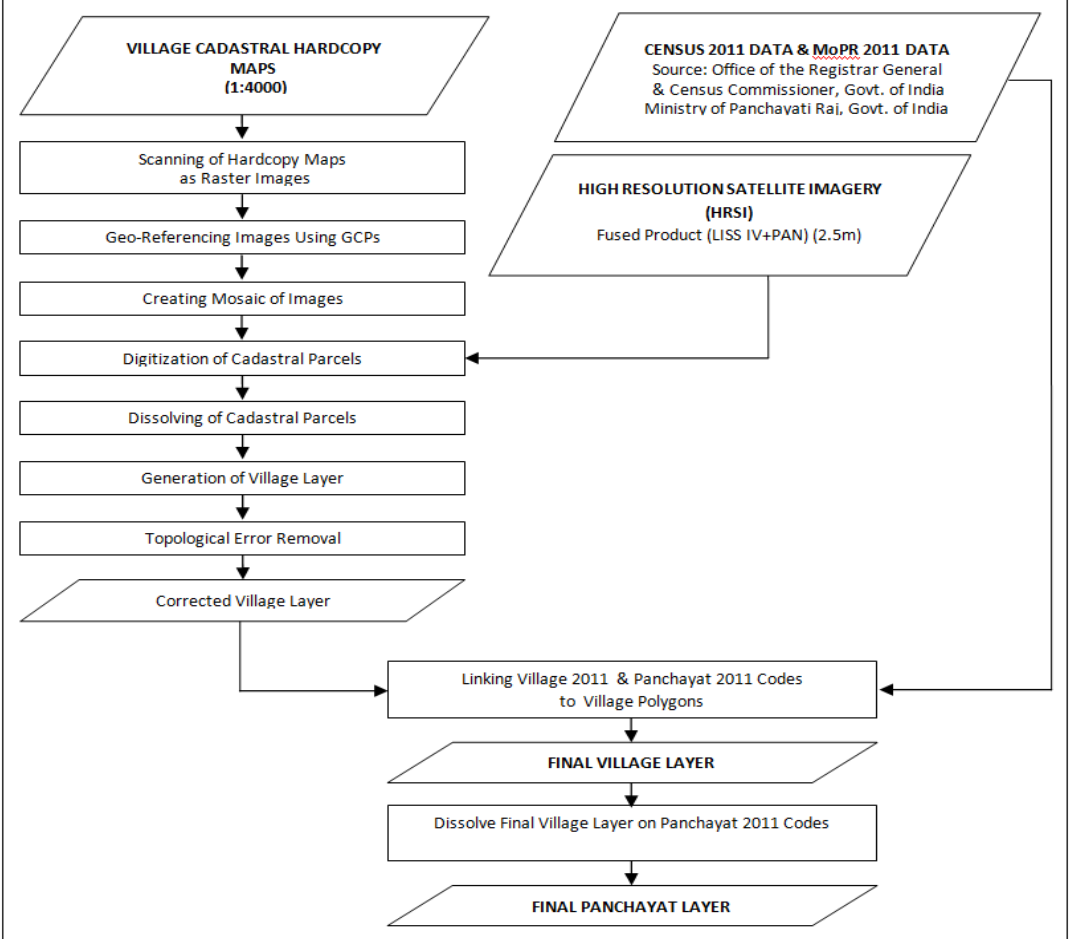
Figure 5: Methodology for generation of village and panchayat layer